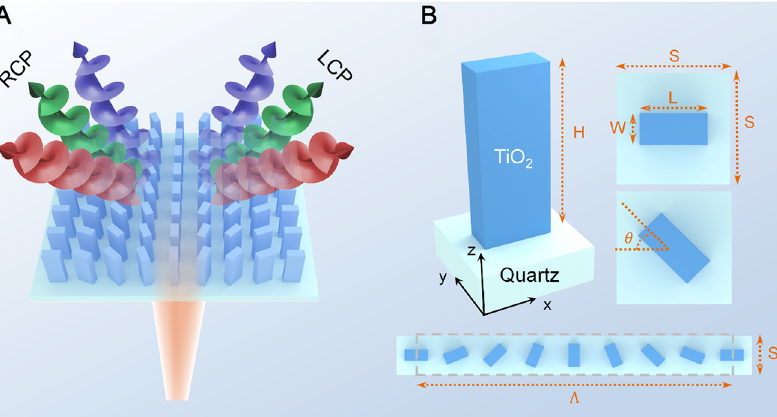
Figure 1: Design of a metasurface exhibiting high-efficiency PSHE. (A) Schematic diagram of the metasurface showing spin-splitting, and its building block of TiO 2 nano fi ns on a quartz substrate. (B) Side and top views of the super- cell of nano fi n grating with periodic dimension Λ × S . Each supercell consists of eight nano fi n elements.Topviewsofanano fi nshowingwidth W , length L with unit cell dimension S × S and the rotation of nano fi n by an angle θ results in the required phase (geometric Pancharatnam- Berry phase). Side view of a TiO 2 nano fi n on a quartz substrate showing height H . Incident plane wave propagates along the z